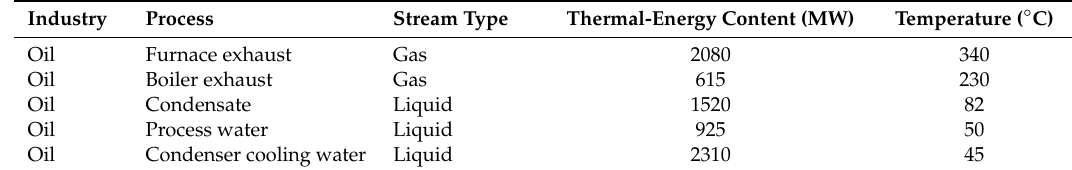
Table 2. Estimates of surplus heat sources in a refinery [20].